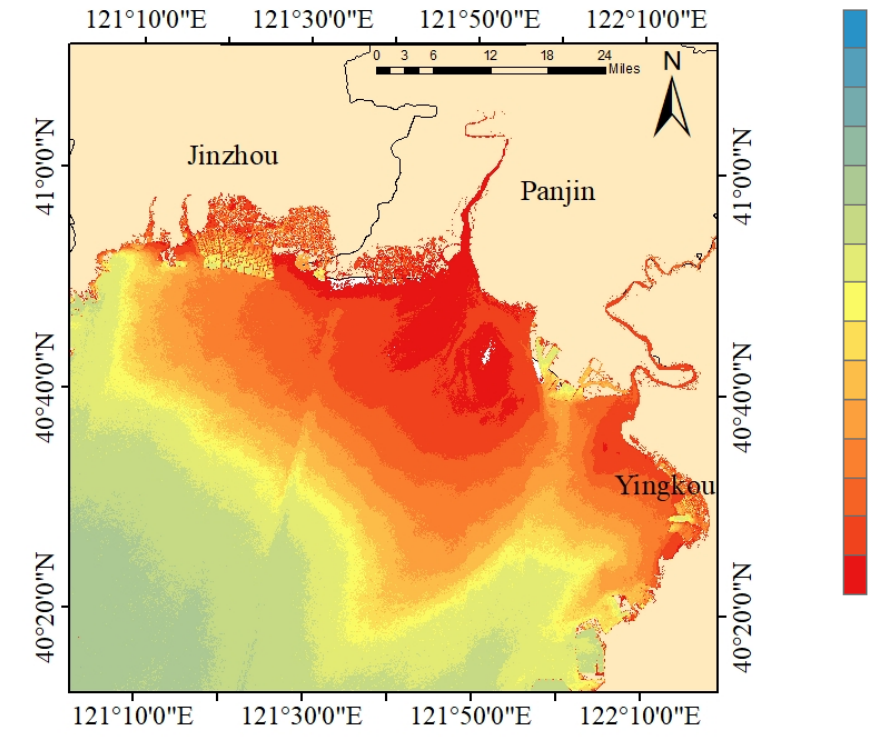
Figure 5. Spatial distribution of FUI in 2018–2020.